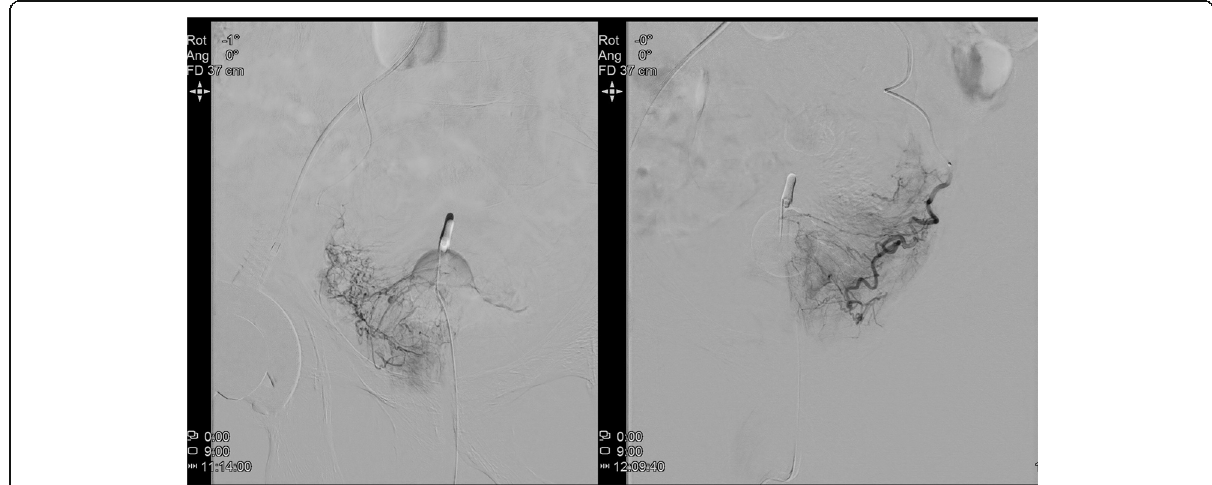
Fig. 1 Selective AP angiograms in Patient 1 with the microcatheter in the right (left panel) and left (right panel) prostatic artery and contrast blush of the corresponding prostate side